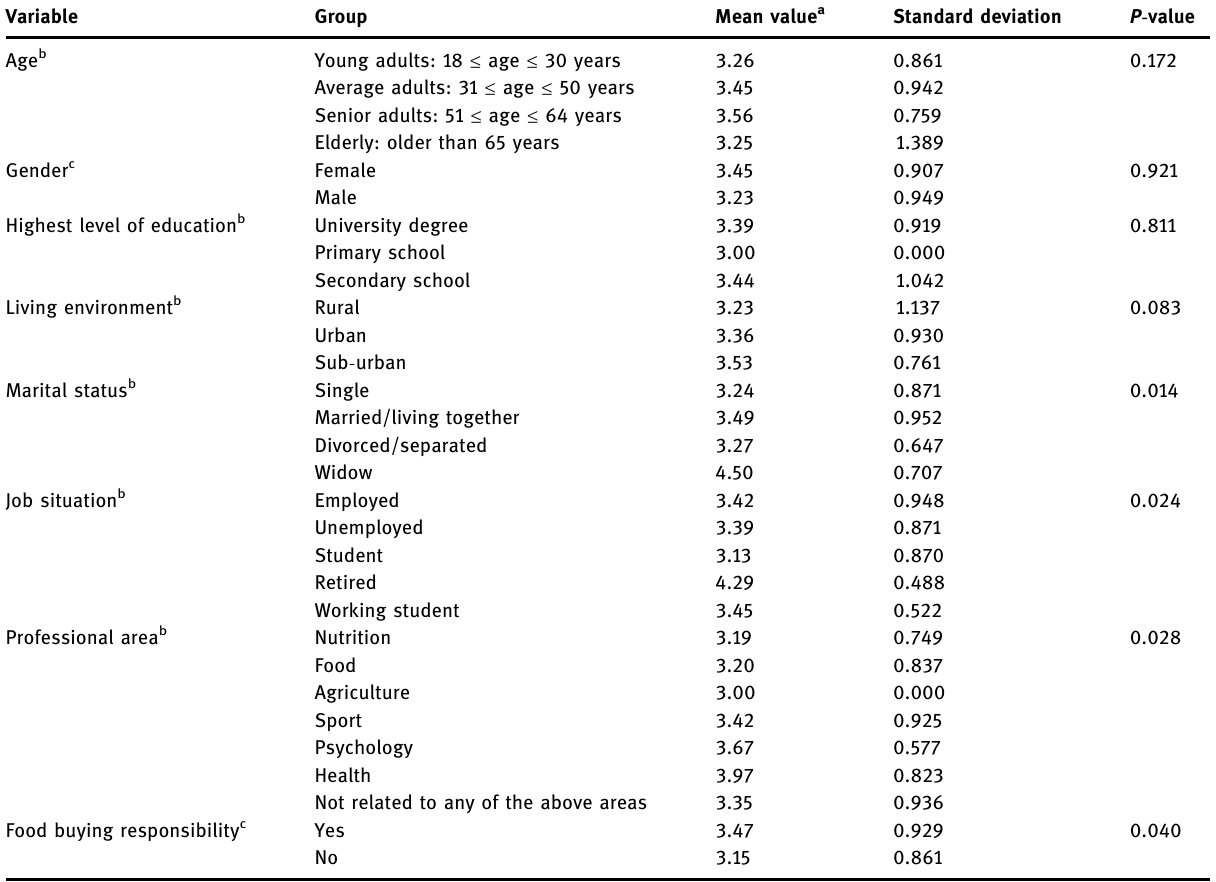
Table 2: Relations between sociodemographic characteristics and the perceptions about a healthy diet